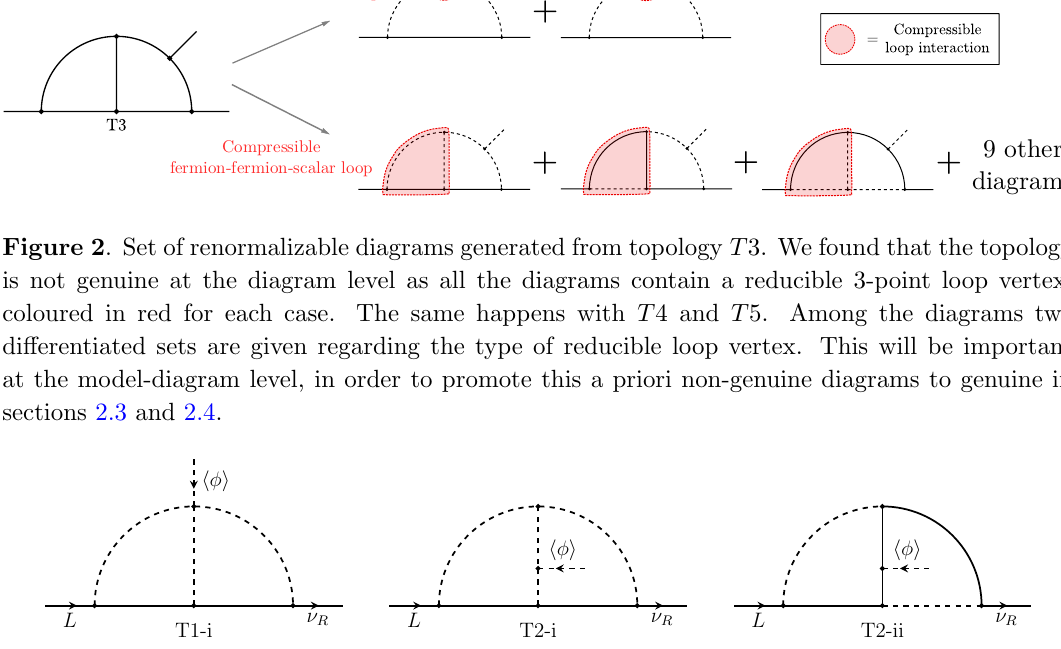
Figure 3 . Set of diagrams which, in general, do not generate a lower order contribution, i.e. they contain no reducible 3- or 4-point renormalizable vertex. However, the tree-level Dirac mass term should be forbidden by some